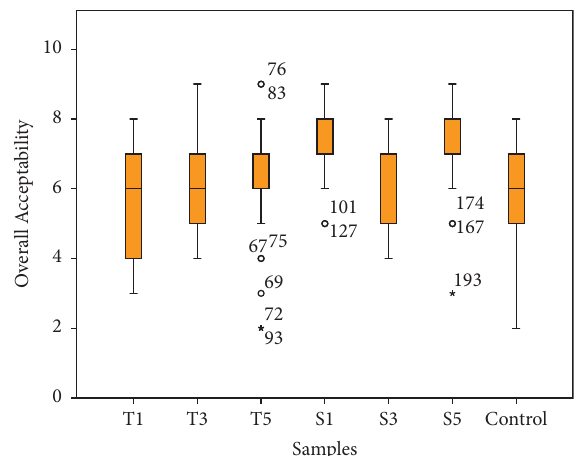
Figure 8: Box-plots obtained for the overall acceptability of pre- pared cake